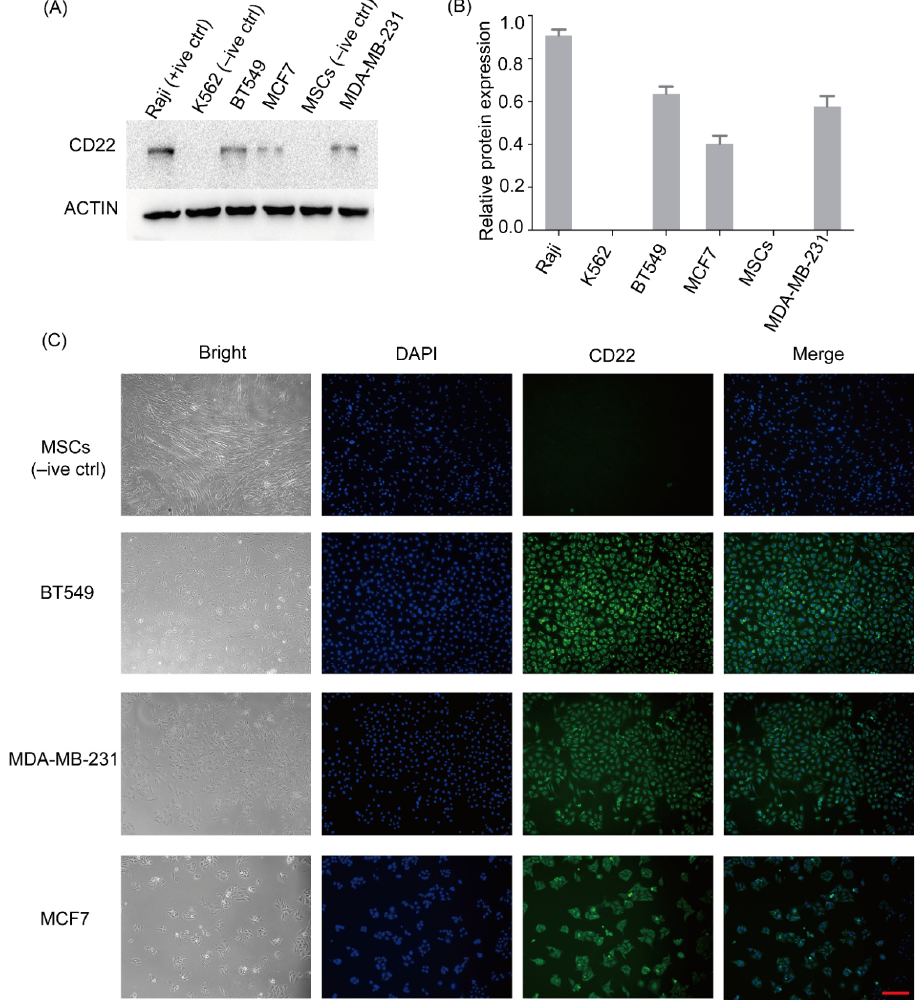
Figure 2. Expression of CD22 in breast cancer cell lines. ( A ) Western blot results for CD22 expression. BT549, MCF7, and MDA-MB-231 were positive for CD22 expression. Raji was used as the positive control, and K562 and MSCs were used as negative controls for CD22. ( B ) Graphical representation of relative CD22 protein expression values from the western blot analysis. ( C ) Representative images of CD22 expression by immunofluorescence of MSCs and breast cancer cell lines: BT549, MDA-MB-231, and MCF7. MSCs (negative control) showed no fluorescence. Membrane expression of CD22 stained in green can be seen in the BT549 and MDA-MB-231cell lines. Cytoplasmic expression of CD22 can be seen in the MCF7. Nuclei were stained with DAPI (4 (cid:48) , 6-diamidino-2-phenylindole) (blue). (Scale Bar: 100 µ